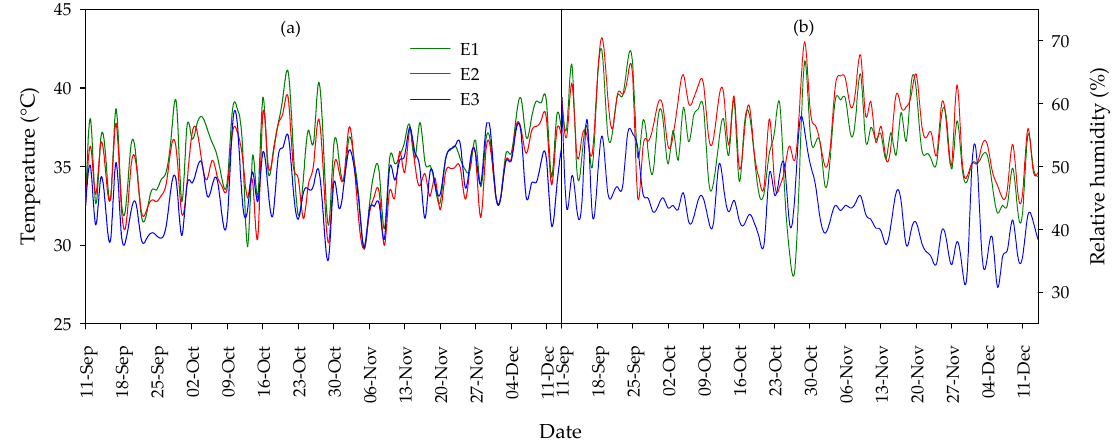
Figure 1. ( a ) Temperature (°C) and ( b ) relative humidity (%) in the growth chambers throughout the duration of the experiment.